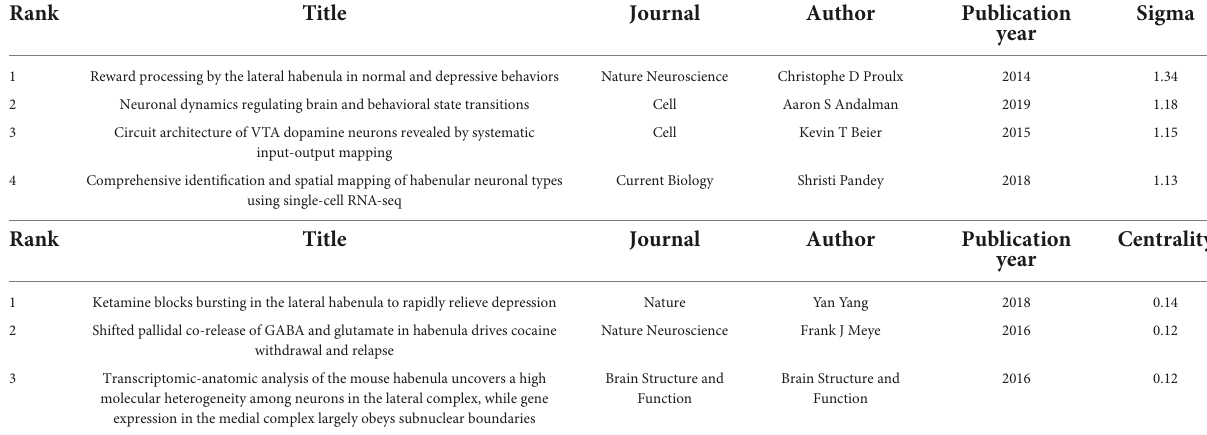
TABLE 2 High-impact references in the co-citation network of habenula research between 2017 and 2022 (ranked by sigma and centrality).